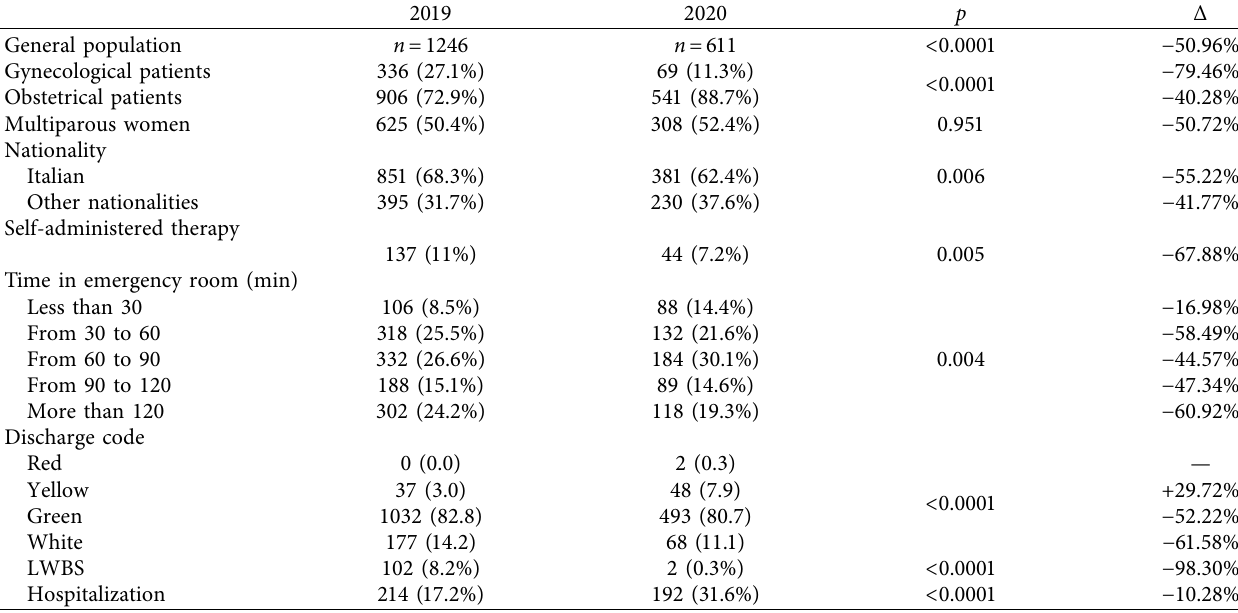
Table 2: General population characteristics.